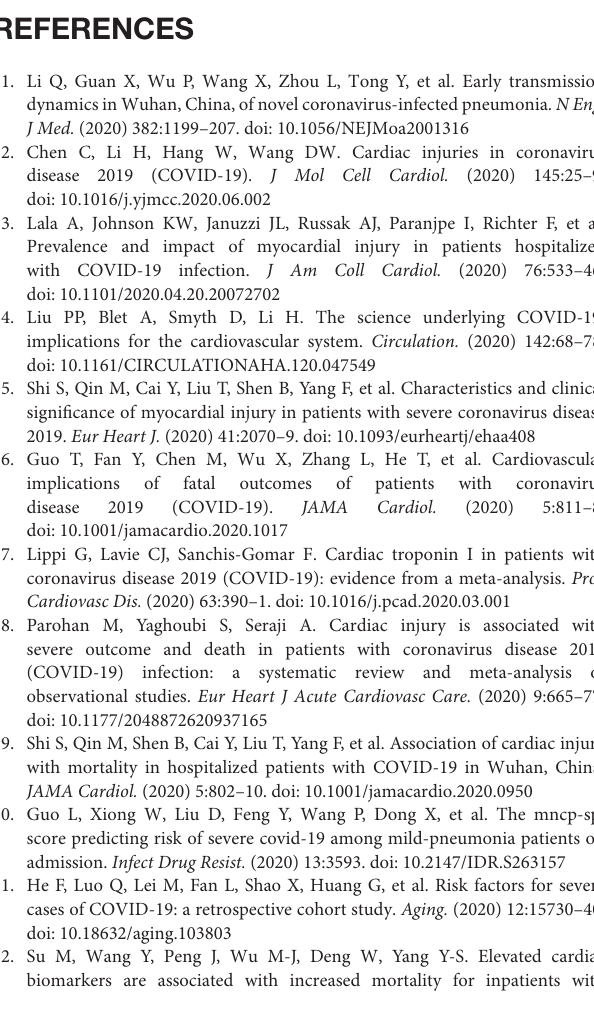
Supplementary Figure 3 | Kaplan-Meier curves showing the cumulative survival of patients divided by ULN. (A-C) Kaplan-Meier curve analysis based on the early-stage levels of myocardial biomarkers. (D-F) Kaplan-Meier curve analysis